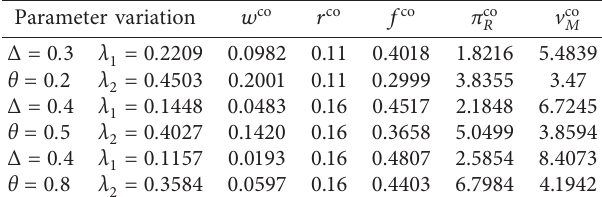
Table 3: Coordinated decision results under revenue-sharing contract.